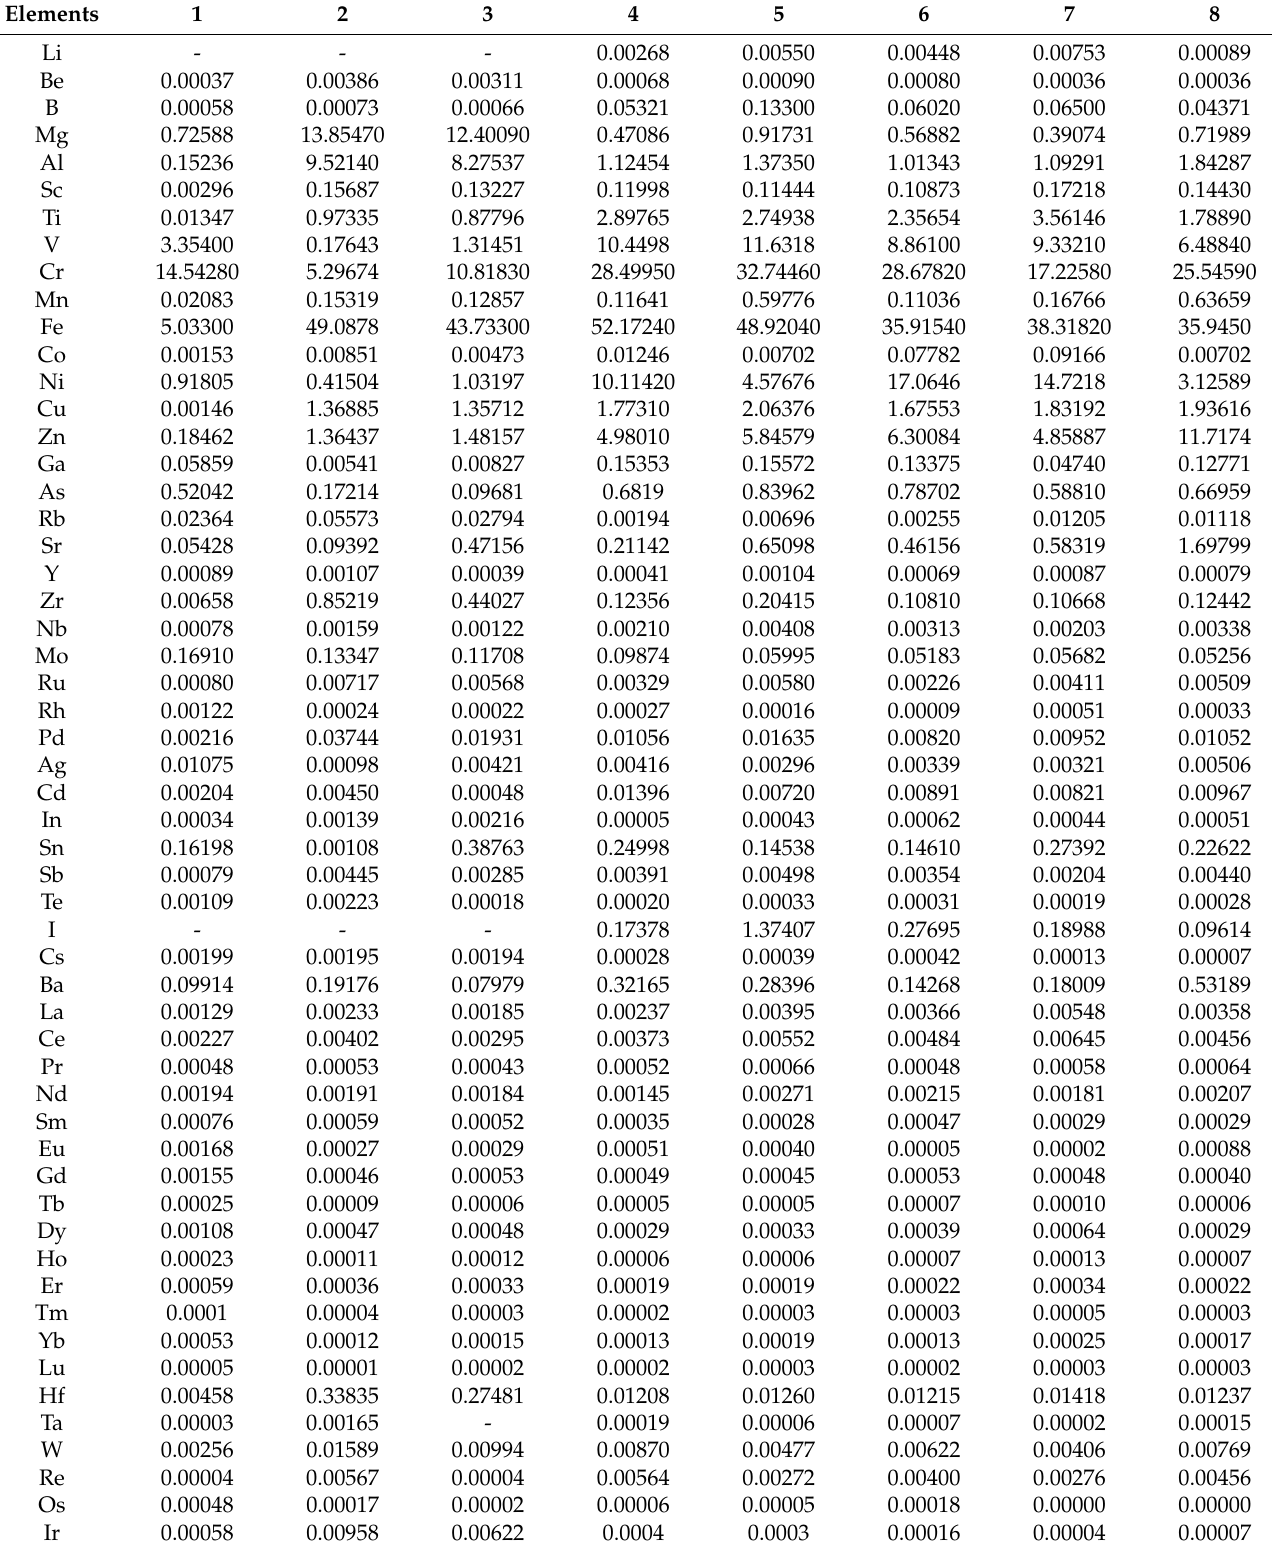
Table 1. Results of ICP-MS (in ppm) for crude oil of Shaimsky